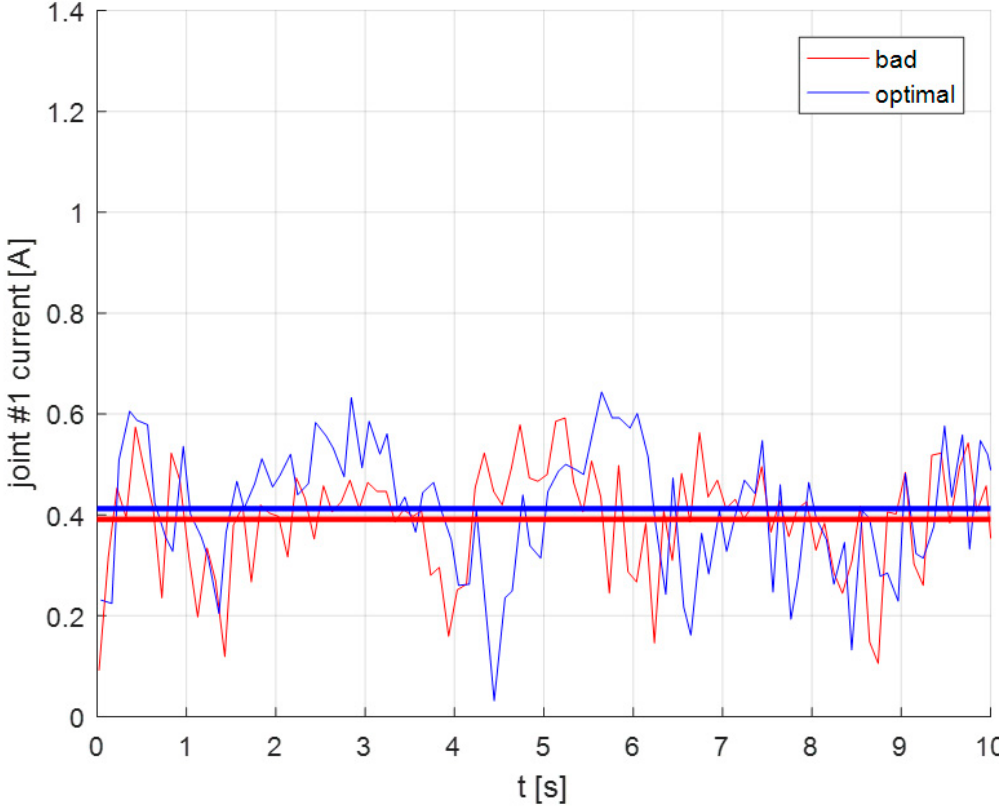
Figure 8 Figure 8. Current utilization and mean current during task execution in both locations for joint